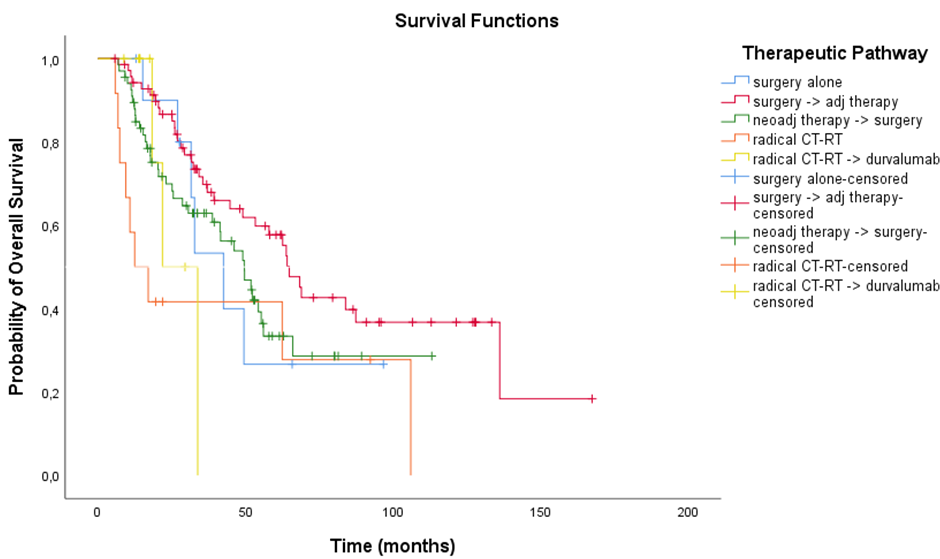
Figure 10. Kaplan–Meier curves of estimated overall survival according to treatment modality in stage IIIA patients. CT-RT, chemo-radiation therapy.